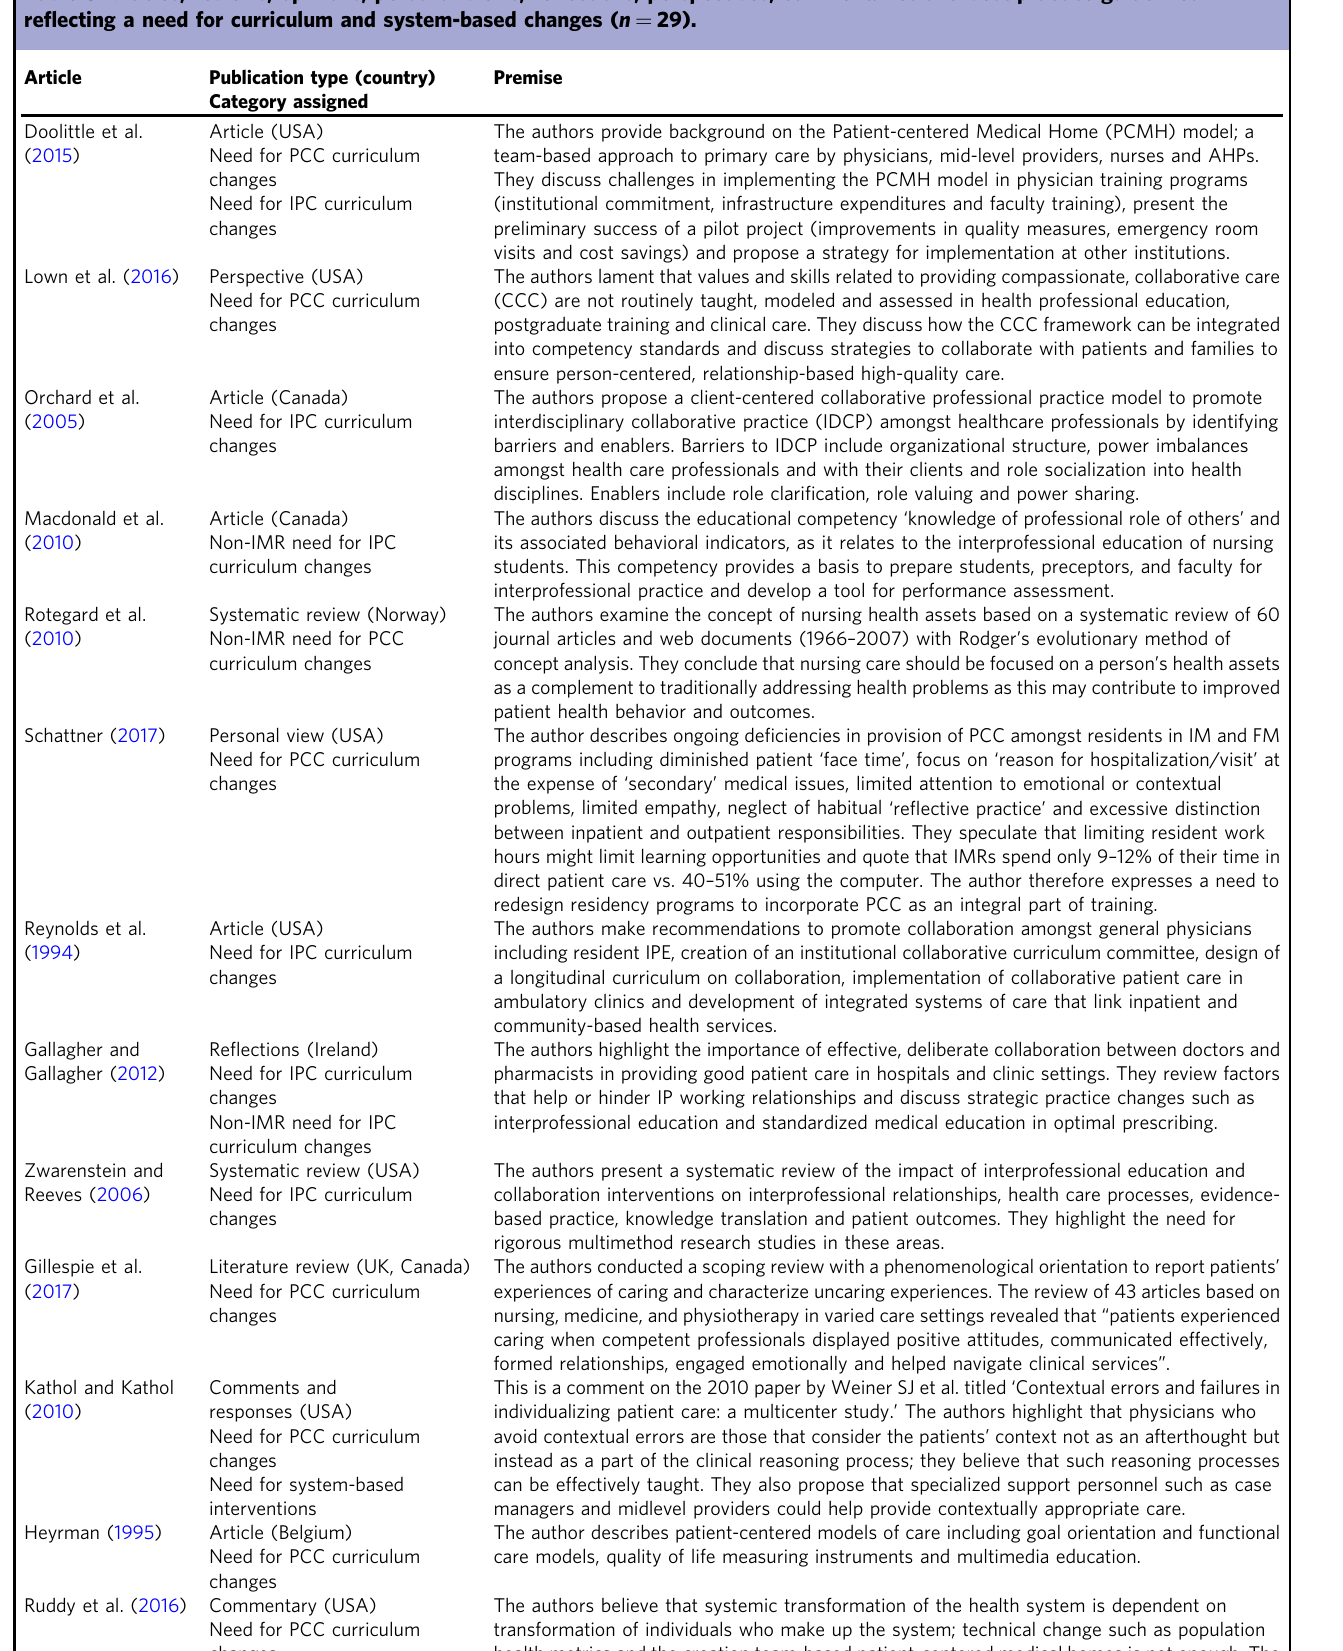
Table 3 Articles, reviews, opinions, personal views, re fl ections, perspectives, commentaries and best practice guidelines re fl ecting a need for curriculum and system-based changes ( n =